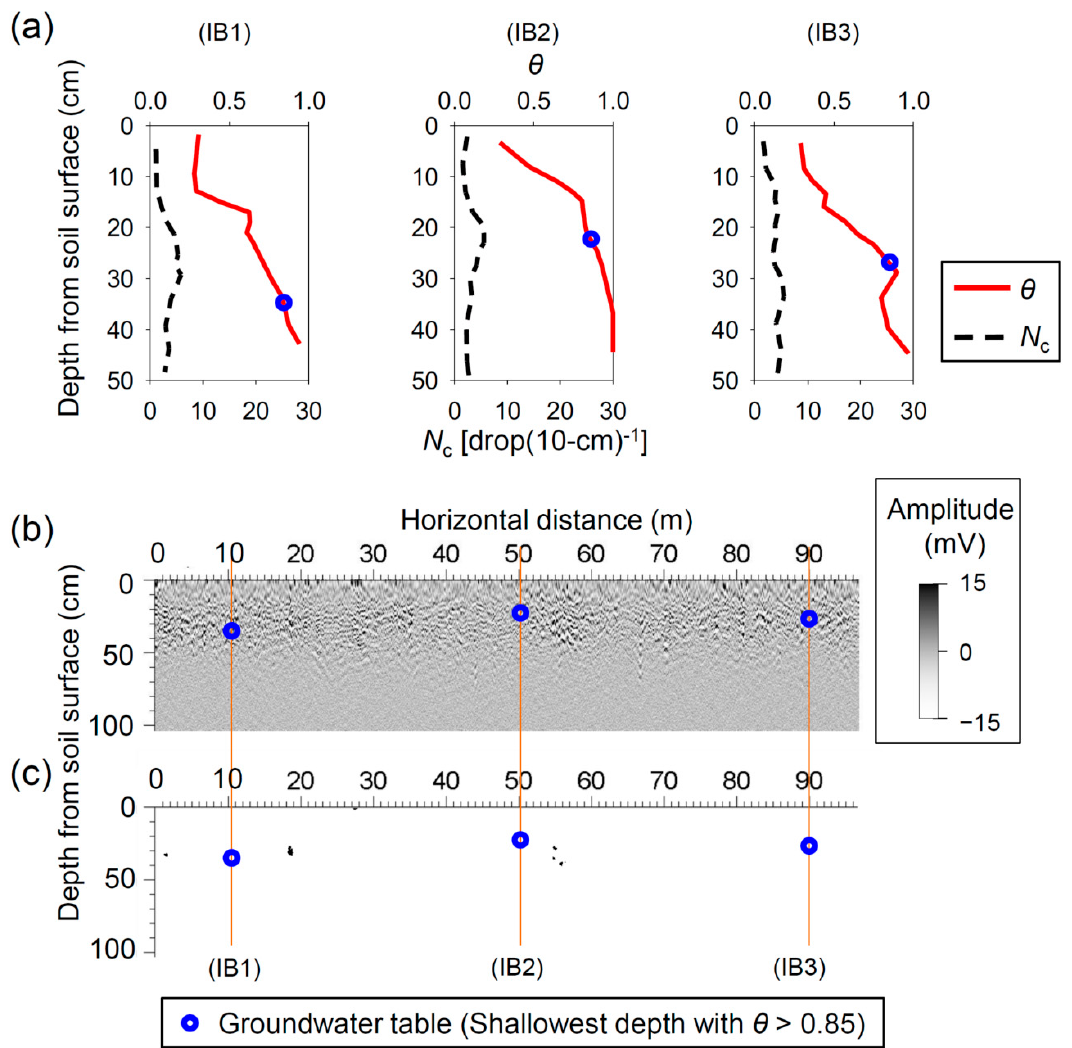
Figure 6. ( a ) Vertical profiles of θ and N C measured by the CPMP, ( b ) radargram, and ( c ) the area in which the median amplitude within a radius of five pixels was > 15 mV in the radargram at the IB site.